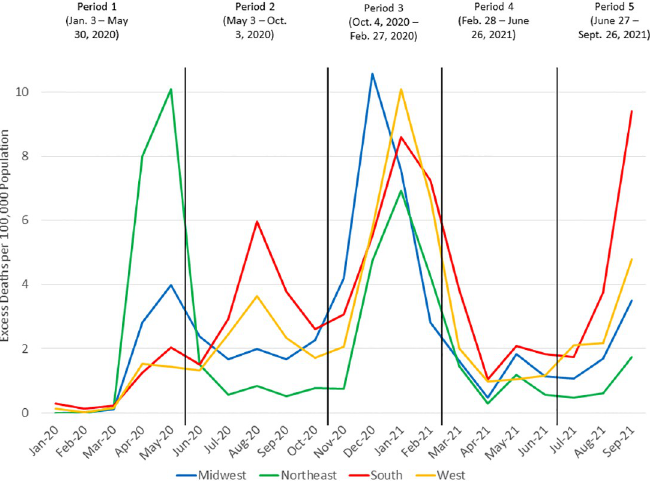
Fig 1. Excess mortality per 100,000 population by week and region, U.S., January 3, 2020 –September 26, 2021. The periods are denoted by vertical lines corresponding to May 30, 2020, Oct. 3, 2020, Feb. 27, 2021, and June 25, 2021. Source: authors’ calculations based on CDC